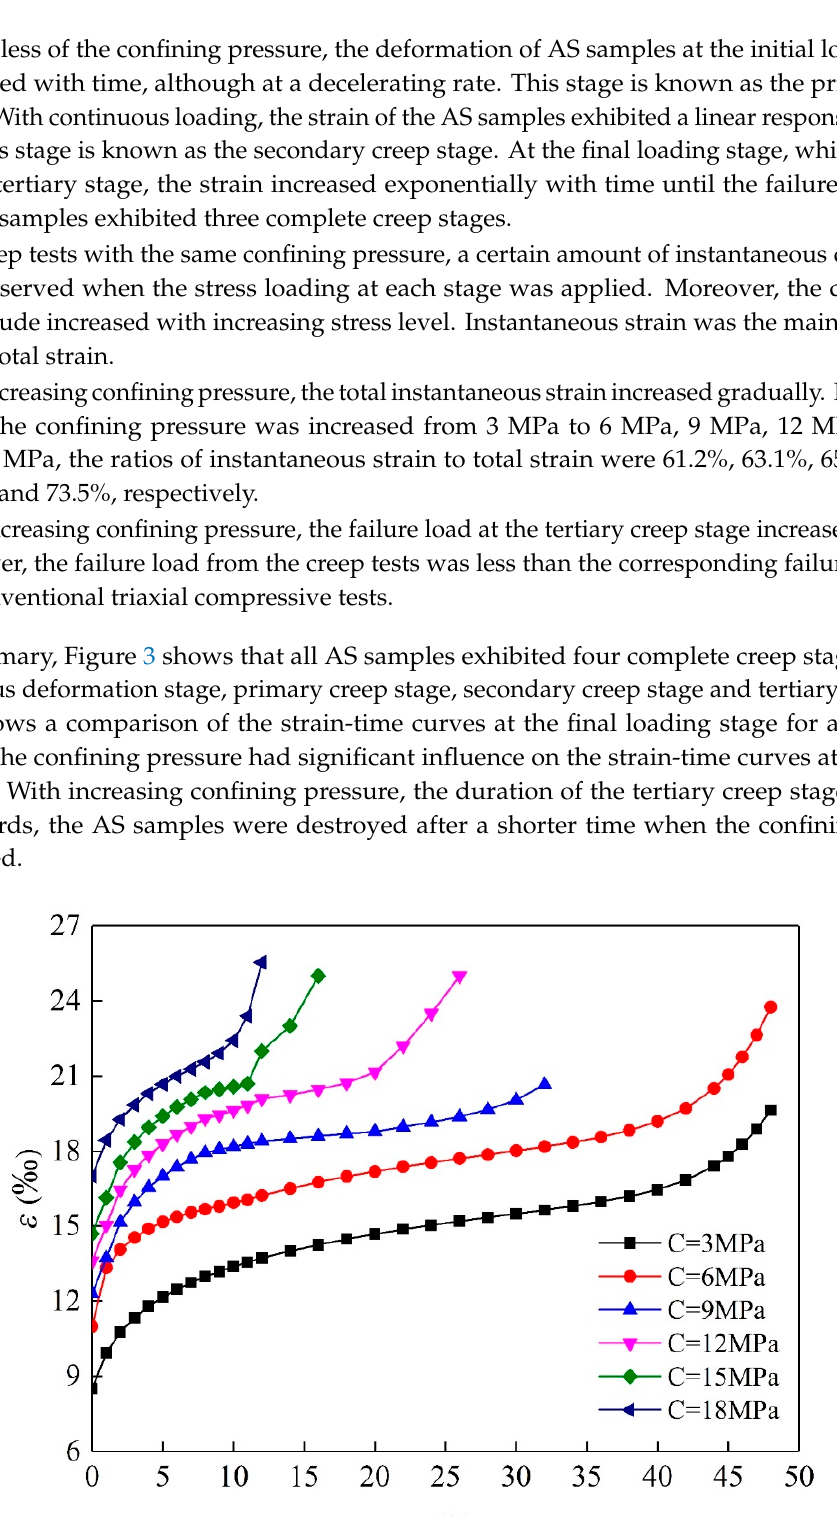
Figure 4. Strain-time curves at the final loading stage for all confining pressures.